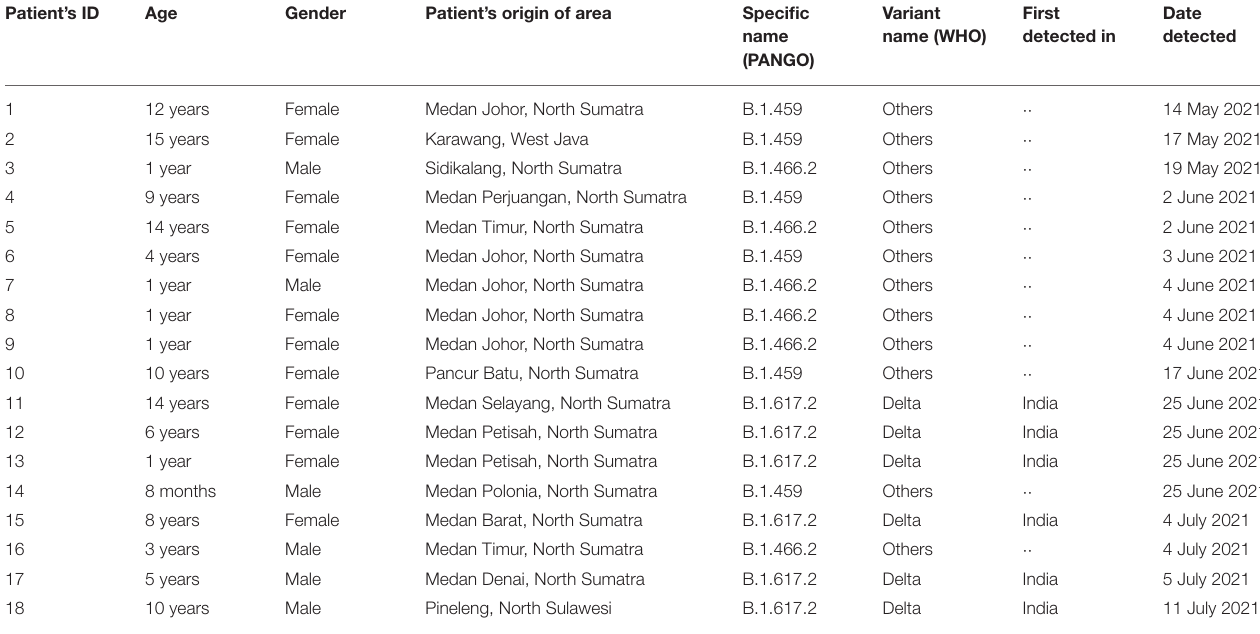
TABLE 2 | Whole-genome sequencing results from 18 children with SARS-CoV-2 infection in North Sumatra, Indonesia. Patient’s ID Age